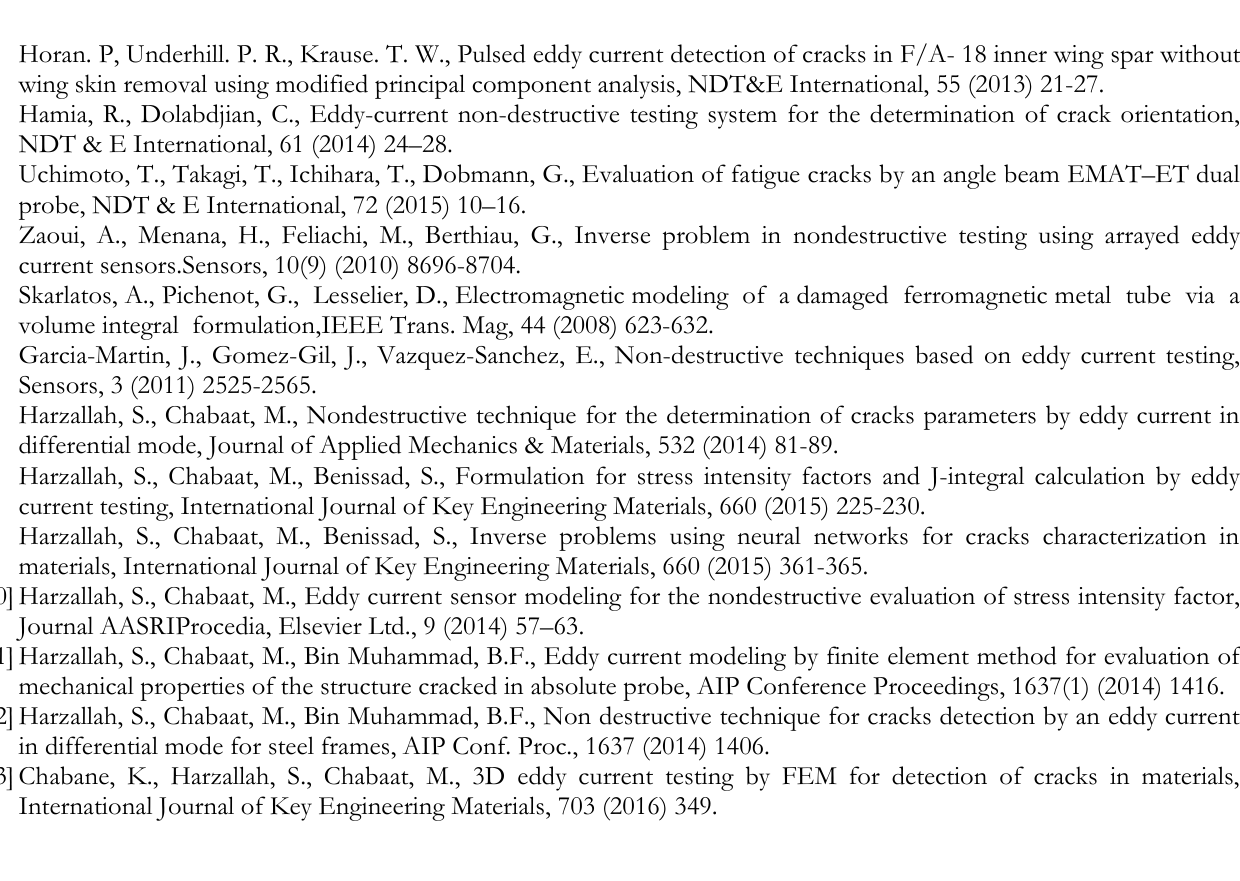
Figure 16: Evaluation of resistance of the sensor vs. crack